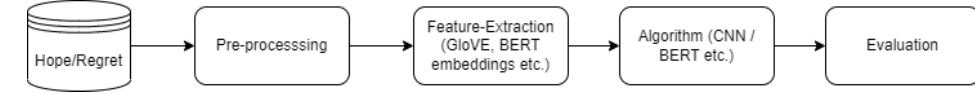
Figure 1. Flowchart of the methodology presented in the